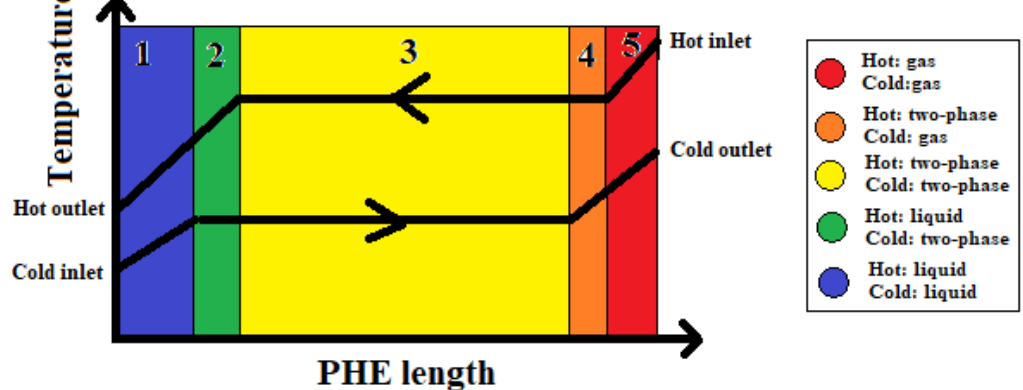
Figure 18. The possible distribution of heat transfer zones in a heat exchanger when both streams change the phase.